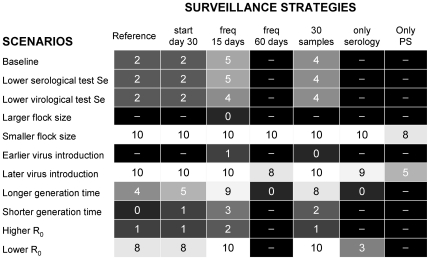
Effectiveness of outbreak detection.Grey-scale plot indicating the maximum number of days after positive sampling to efficiently stop the infection (i.e. last day at which Rh<1) for alternative surveillance strategies under different scenarios. Footnote: The number reported in each cell represents the last day at which Rh<1 for that specific combination of surveillance and scenario (light = better, dark = worse).